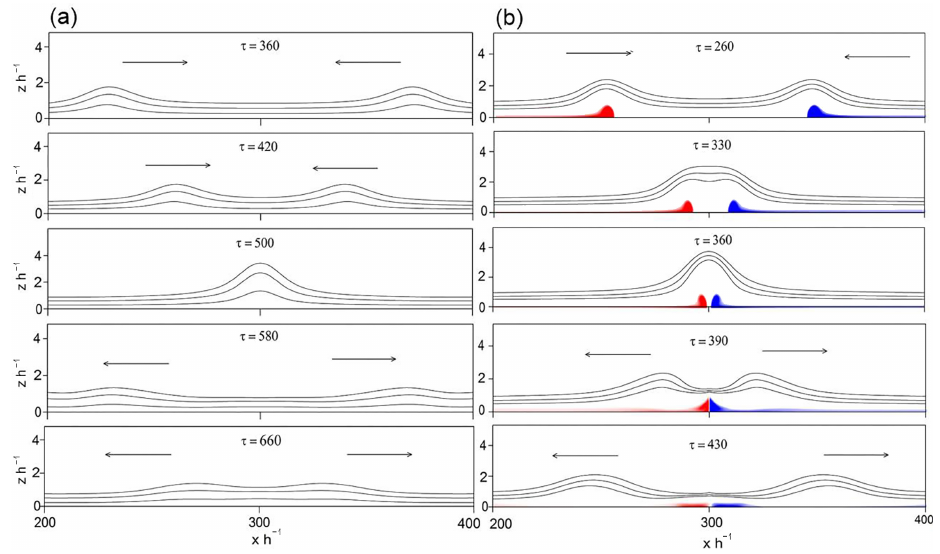
Figure 2. Snapshots of the density isopycnals during the collision of ISWs. (a) Case (A2; A2). (b) Case (A5; A5). The trapped cores are visualized by dyed fluid.